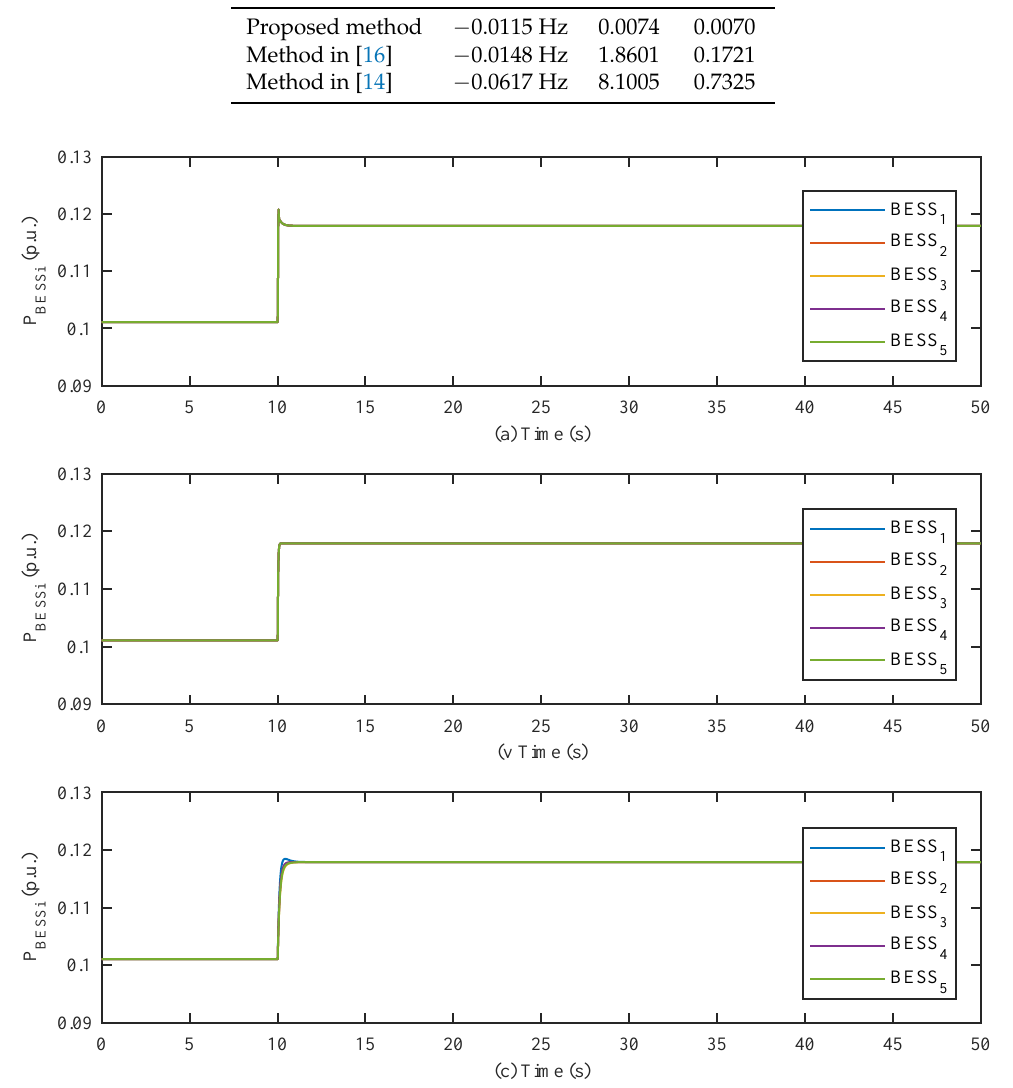
Figure 15. Convergence curve of incremental cost. ( a ) Convergence of incremental cost with the proposed method. ( b ) Convergence of incremental cost with the method in [16]. ( c ) Convergence of incremental cost with the method in